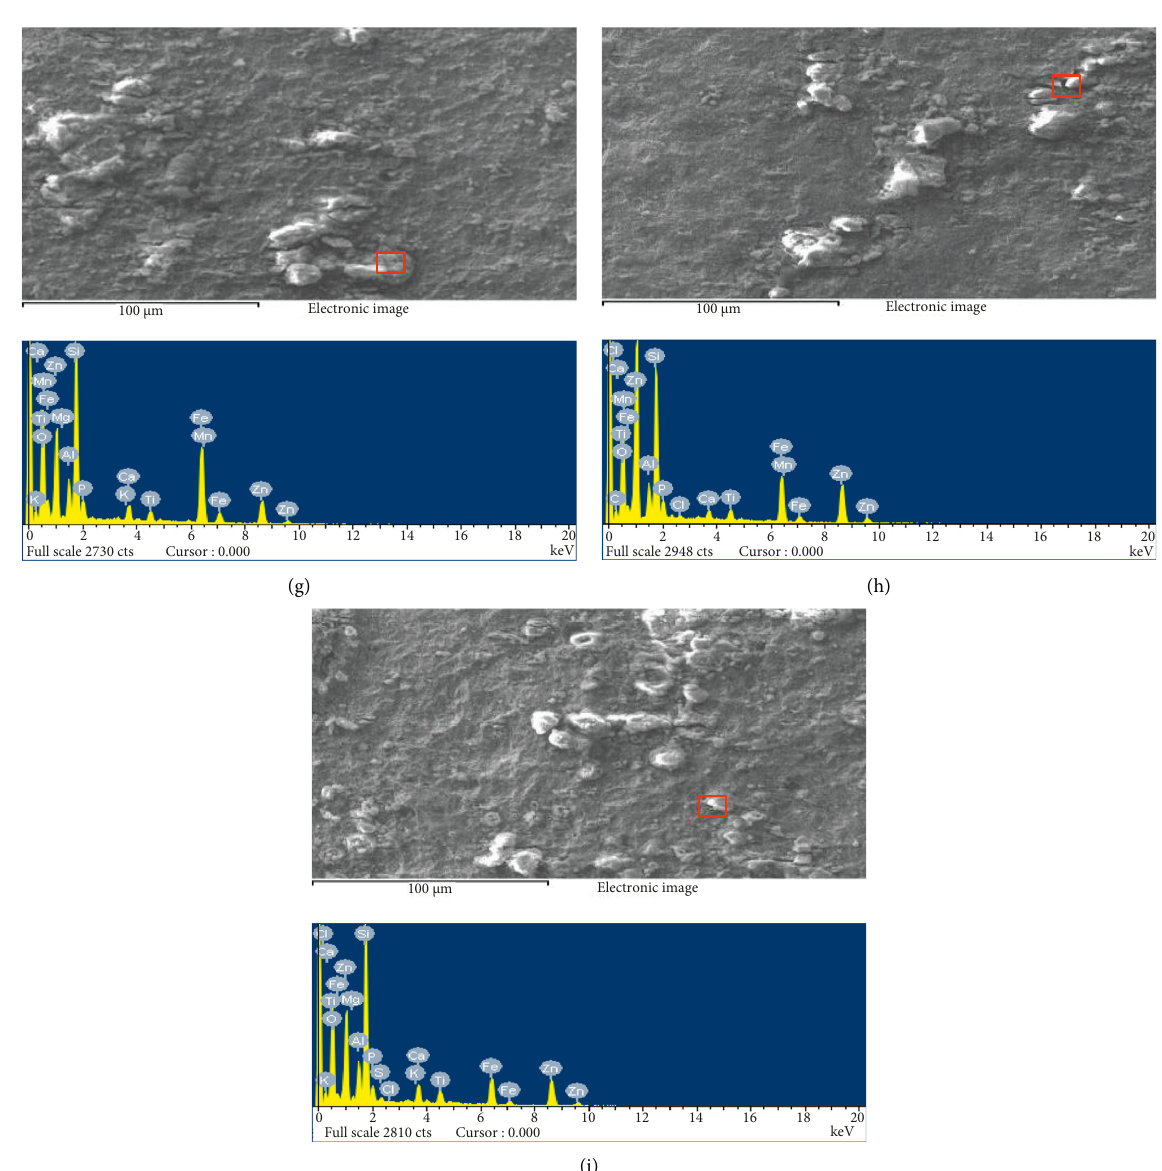
Figure 8: EDS spectra of carbon steel at different corrosion times. (a) 0 h. (b) 1 h. (c) 2h. (d) 4h. (e) 8h. (f) 12h. (g) 24 h. (h) 48h. (i)